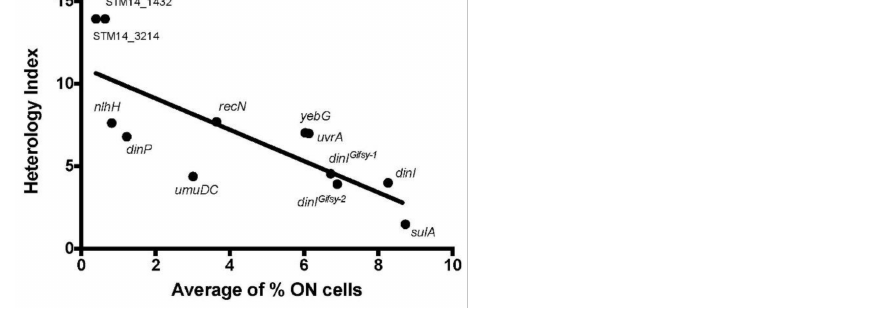
Figure 5. Correlation between the HI values of the SOS boxes and the size of the ON subpopulations of genes with LexA-dependent bistability (group I).